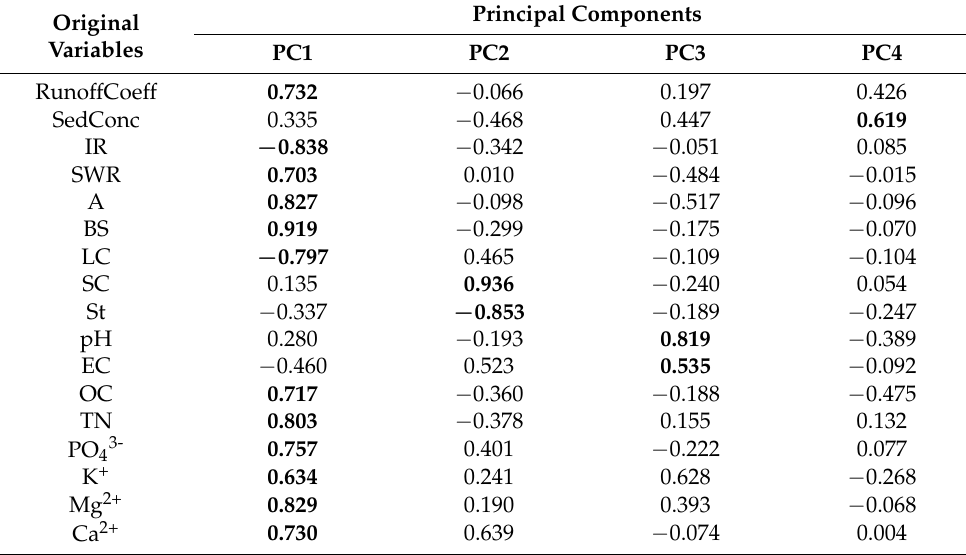
Table 4. Factor loadings of the soil properties on the first four Principal Components provided by the PCA applied to soil covers and properties, and hydrological variables observed in the experimental sites immediately after the prescribed fire and mulching treatment (Samo, Calabria, Southern